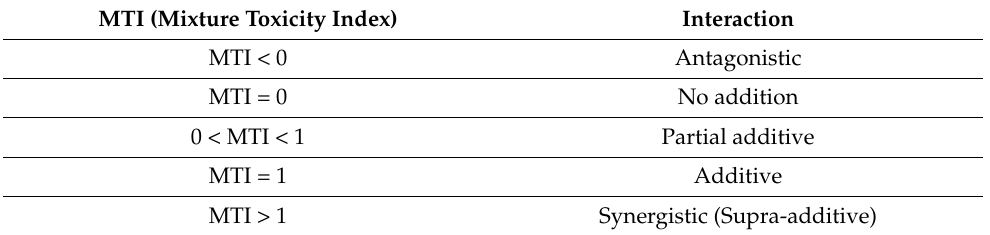
Table 2. Mixture toxicity indices and interaction existing between compounds